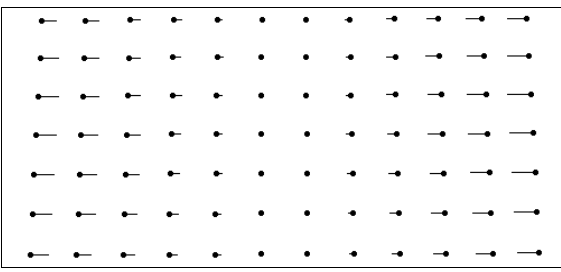
Figure 11: Effect of insufficient distortion correction of CS 2 : the vectors indicate epipolar line error scaled by factor ten, epipolar lines run vertically, image section is cutted above and